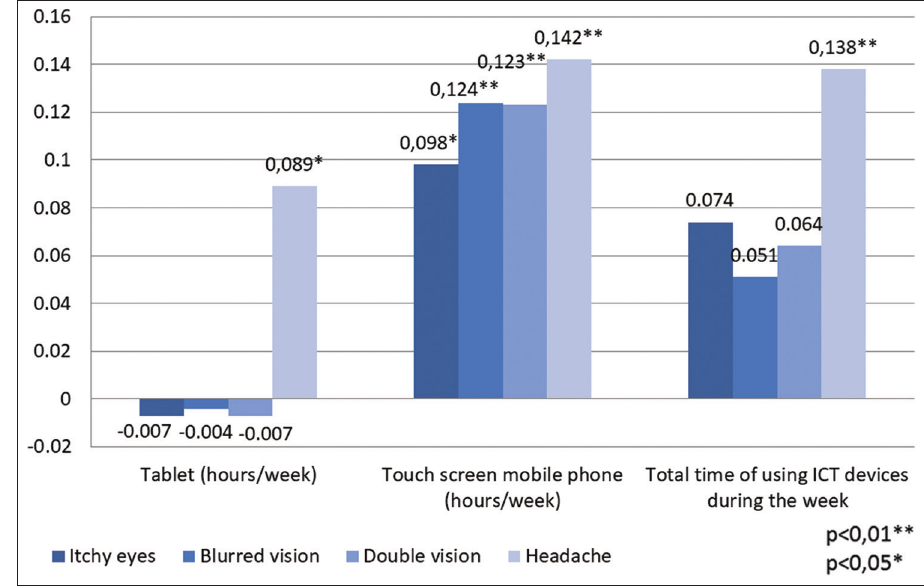
CHART 3. Correlation analysis of eye symptoms and headache of statistically significant variables in relation to the time of used ICT